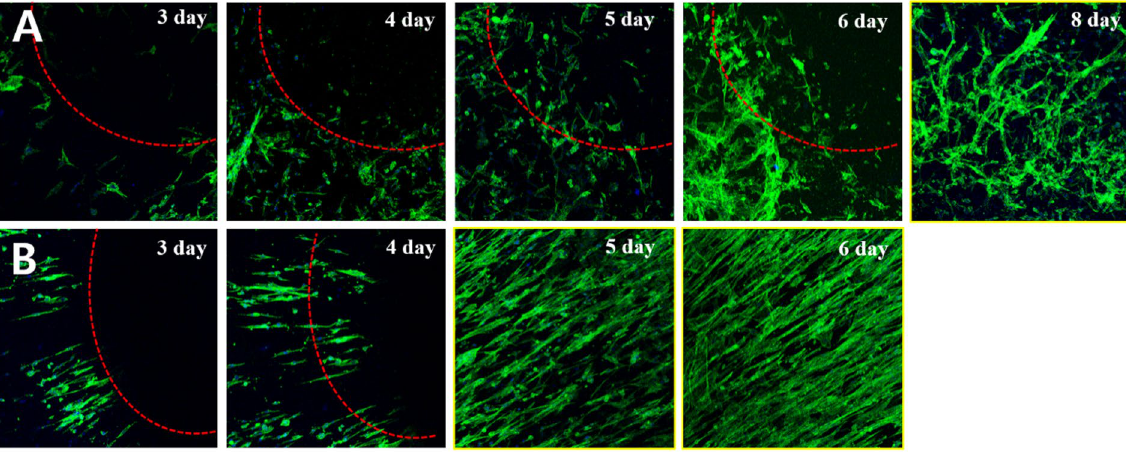
Figure 7. ( A , B ) Fluorescence images comparing the cell migration when rCCs were cultured on the membranes of randomly oriented and radially aligned fibers, respectively, for 8 days. The scratch test adapted to the mats with a 5 × 3 × 3mm 3 stainless steel strip for cell migration studies along their surface